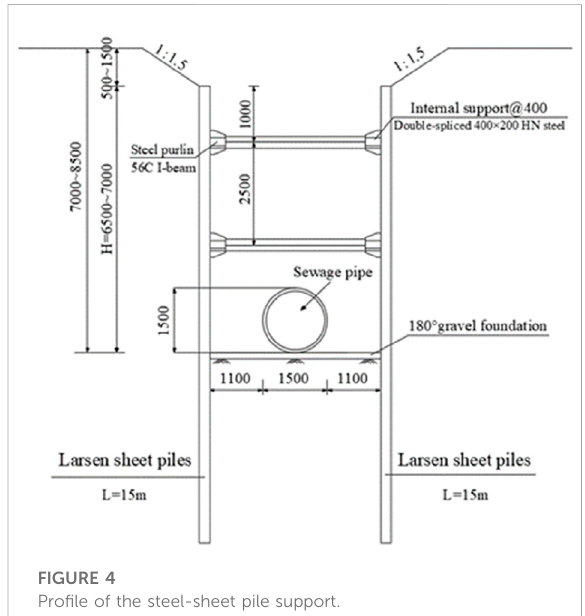
FIGURE 4 Pro fi le of the steel-sheet pile support.